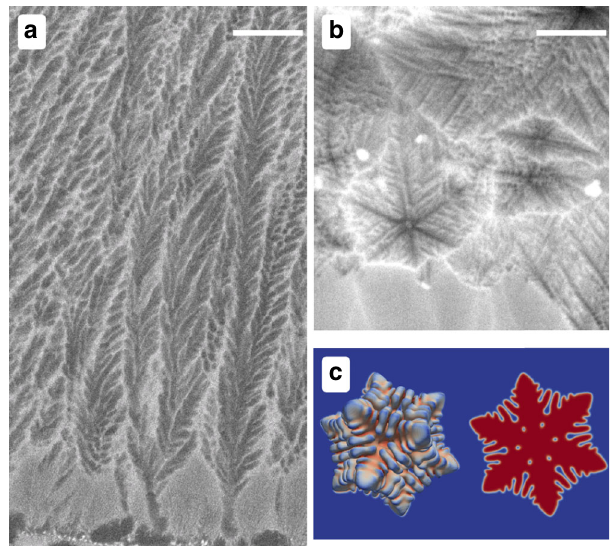
Fig. 1 Dendrite orientation transition in Al – Sm alloys. a A columnar dendritic microstructure obtained in a laser remelted Al – 2.2 at.% Sm alloy. The microstructure shown here is consistent with a seaweed structure, closely related to a hyper-branched dendritic structure described by Haxihimali et al. 12 . The scale bar indicates 10 μ m . b Equiaxed h 110 i dendrites observed in a laser remelted Al – 5.6 at.% Sm alloy (scale bar 2 μ m ). c A three-dimensional dendrite from a phase- fi eld simulation, with a section showing the highlighted six h 110 i branches. The microstructure in ( b ) is composed of h 110 i dendrites is veri fi ed by the observed sixfold